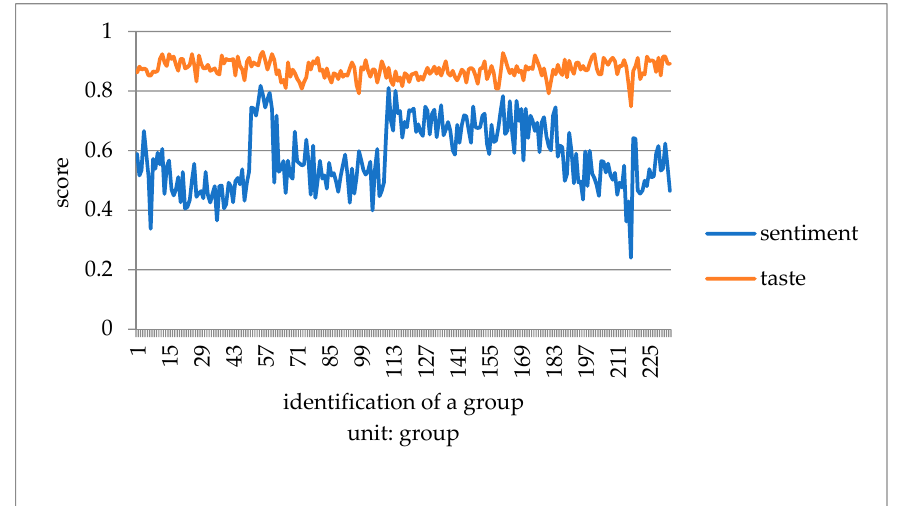
Figure 9. Chart of emotional score and restaurant service before COVID-19.